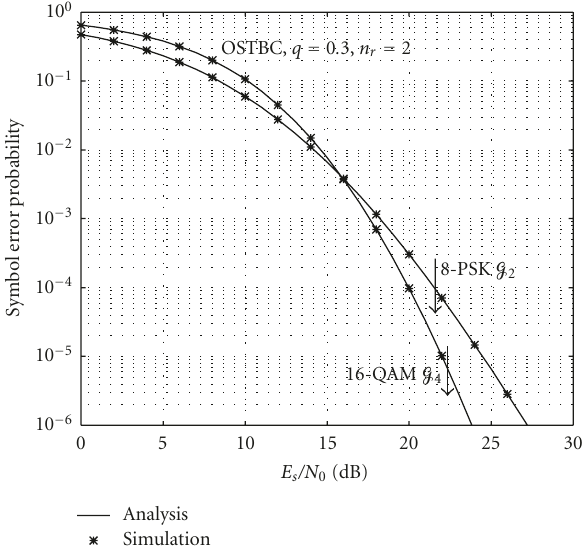
Figure 2: Symbol error probability of 8-PSK G 2 and 16-QAM G 4 OSTBCs (3bits/s/Hz) versus E s /N 0 in MIMO Nakagami- q fading channels. q = 0 . 3 and n r =